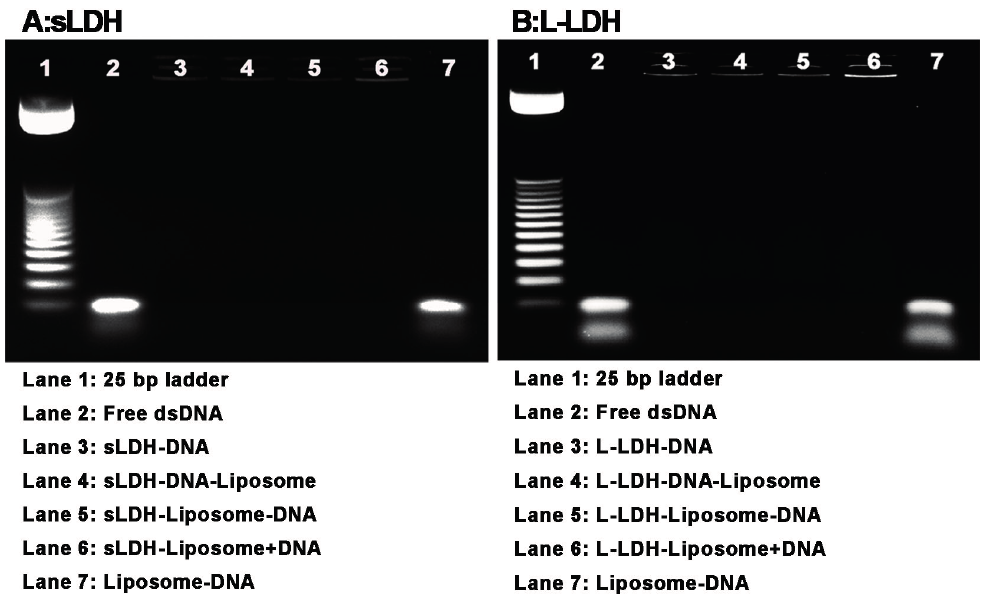
Figure 5. Electrophoresis mobility of the HFDM LDH–liposome composite for dsDNA loading (LDH:DNA mass ratio = 20:1; EPC:DNA mass ratio =